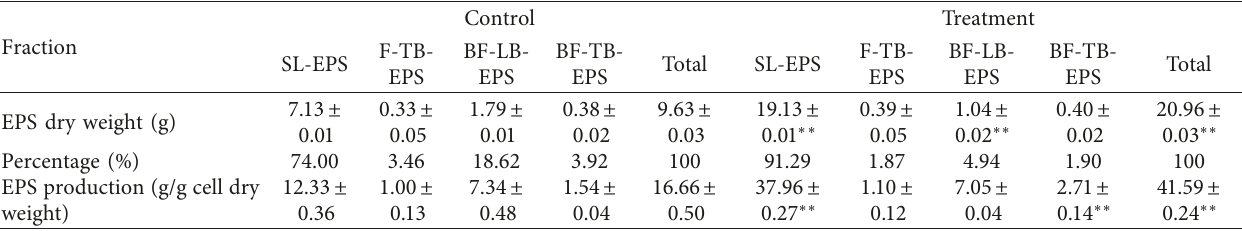
Table 2: EPS production per biomass of diatom Stauroneis sp. incubated in the presence of bacterial supernatant crude extract.